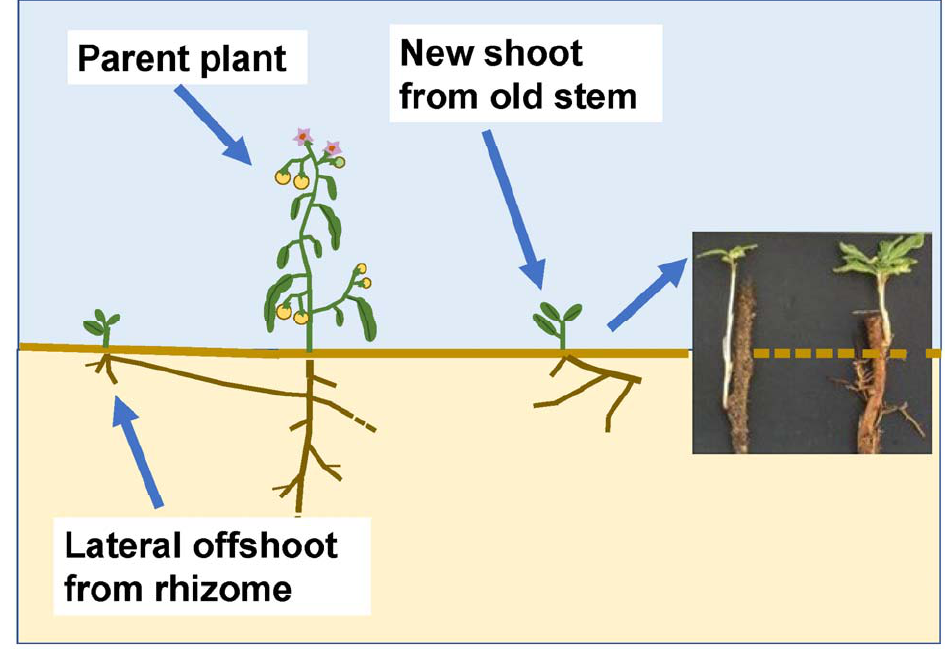
Figure 2. Illustration of Solanum elaeagnifolium showing new shoots produced by old stems and lateral offshoots emerging from rhizome. We performed data analyses and visualizations using R-Studio version 4.0.3